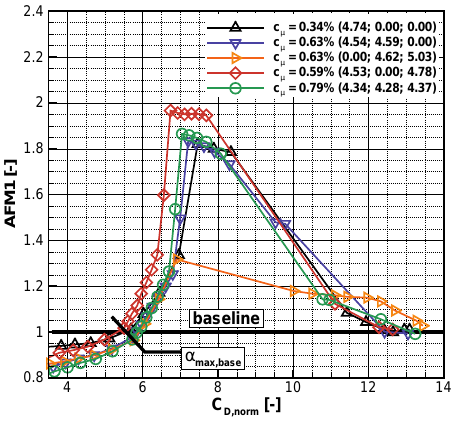
Figure 25. First aerodynamic figure of merit for a constant jet velocity ratio.